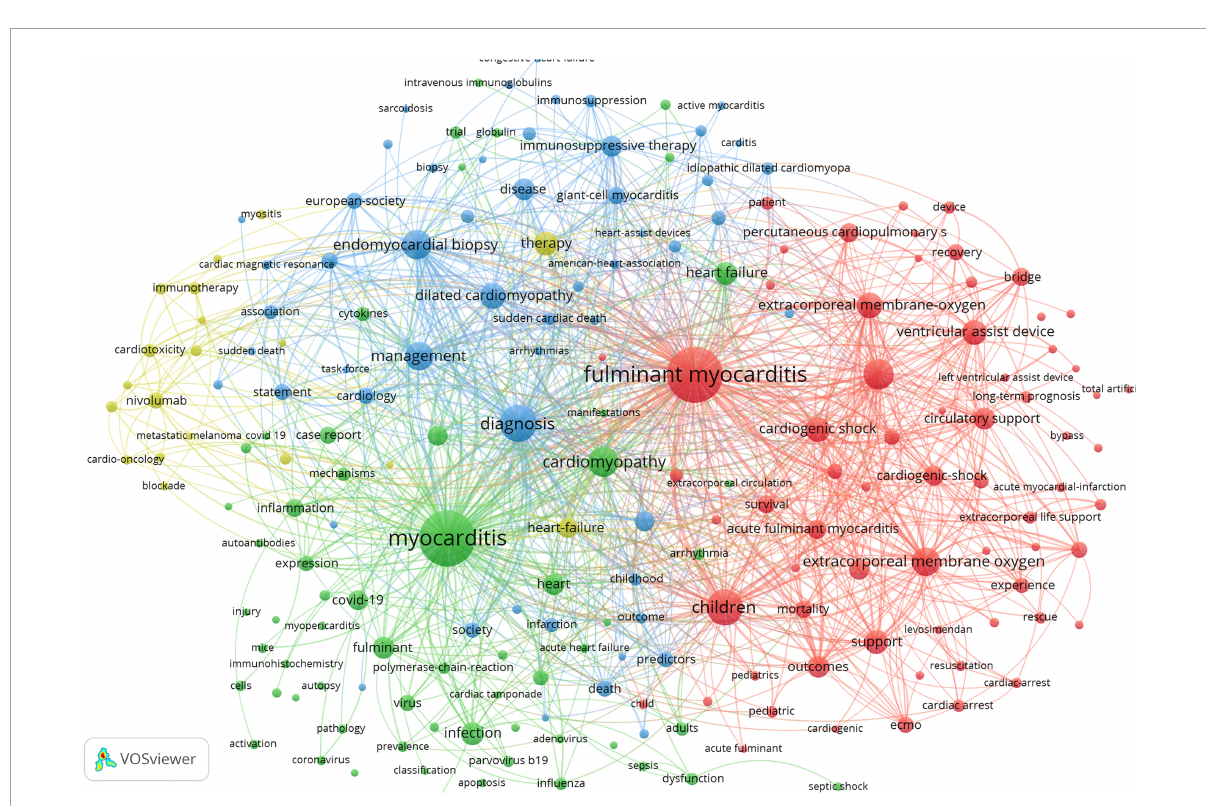
FIGURE5 Co-occurrence network of the terms with occurrences of 5 or more extracted. The larger circle size or font size indicates a higher